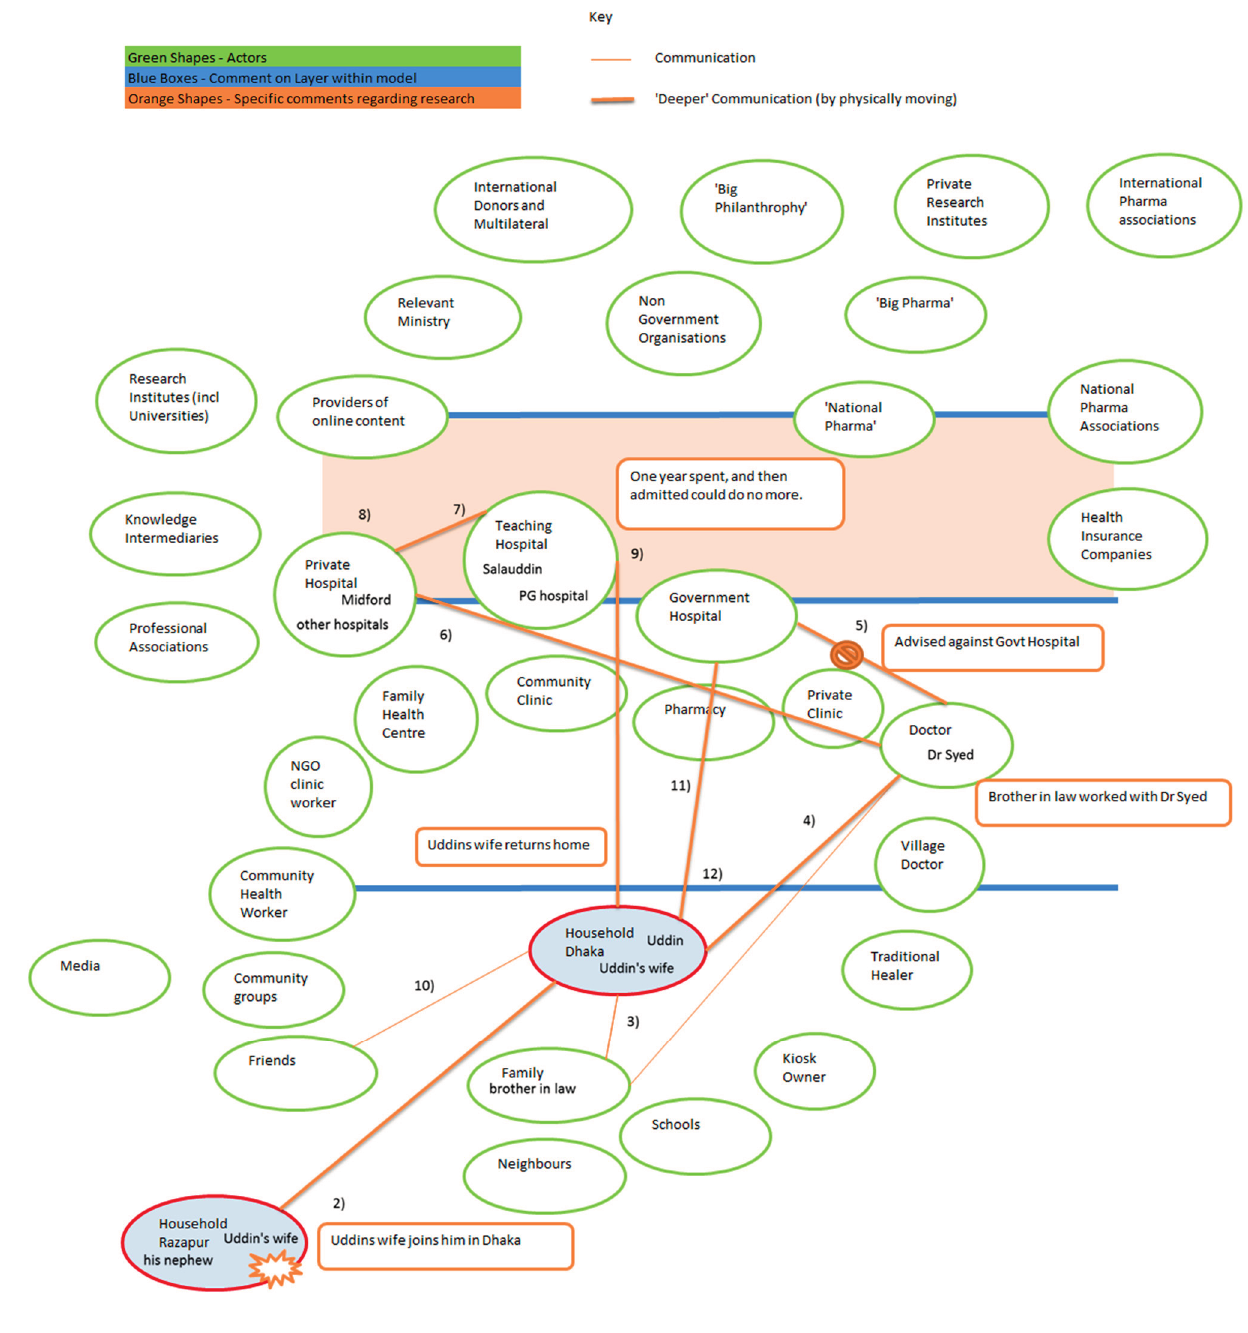
Figure 3. ( a ) Uddin’s story-Part 1 Identifying the health problem; ( b ) Uddin’s story-Part 2, the long road to